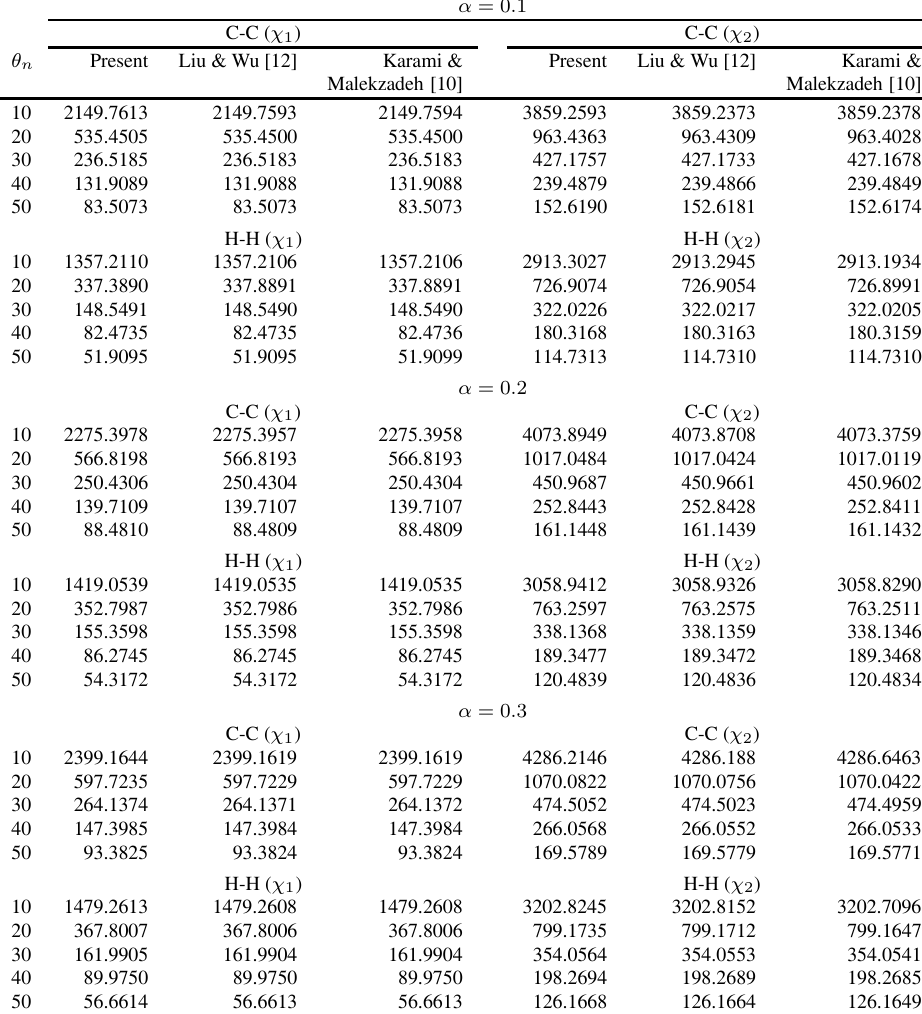
Table 4 Natural frequencies of a symmetric tapered